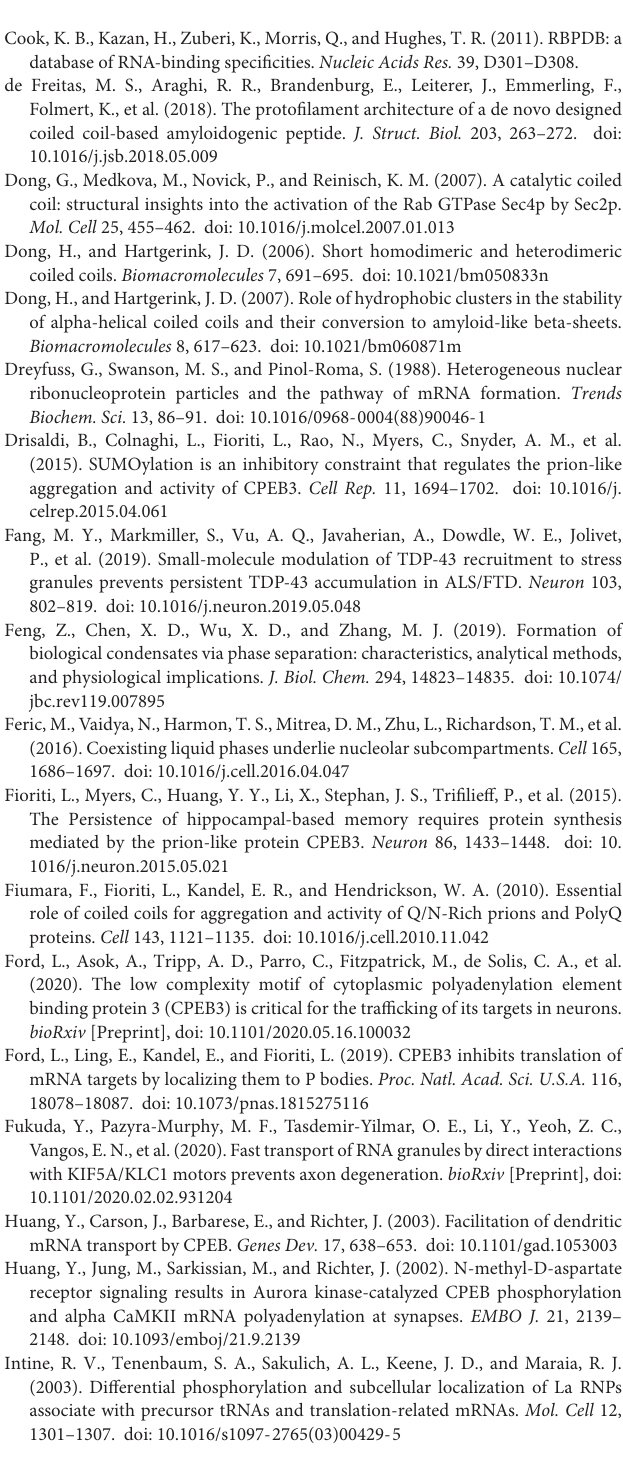
Supplementary Figure 2 | (A) The chart shows the percentage of proteins with cc motifs in RBP, based on the type of organelle in which they resides. Neuronal RNPs, chromatoid bodies, cytosolic RNP, and Piwi-containing P granules possess the highest percentage of components with predicted CC motifs. The Software AmiGo2 was used to download the RBP distributed in each